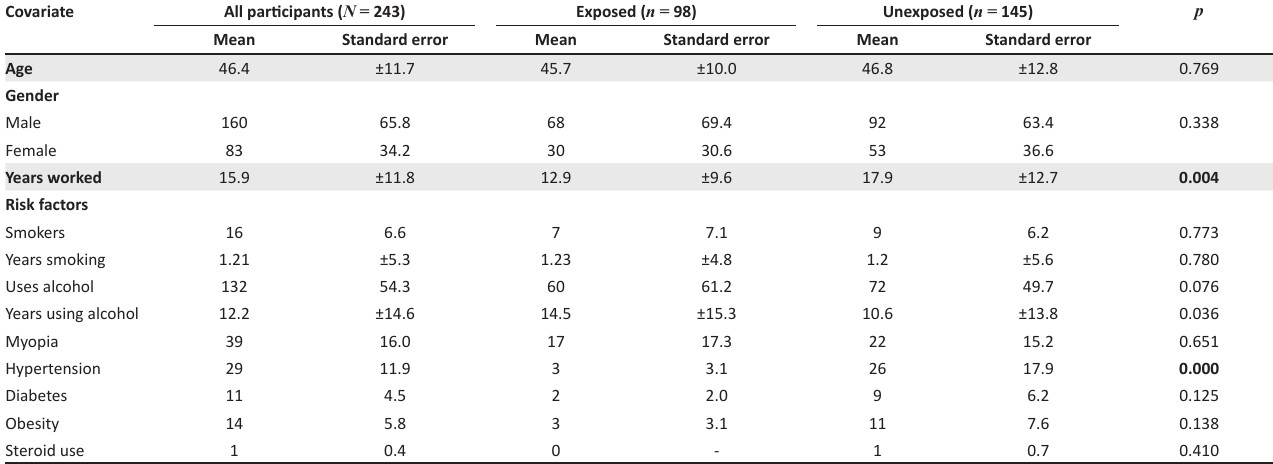
TABLE 1: Demographics and risk factors with percentages for categorical variables and mean ± standard error for continuous variables. The p -values are for comparison of exposed and unexposed groups. Covariate All participants ( N = 243) Exposed ( n =